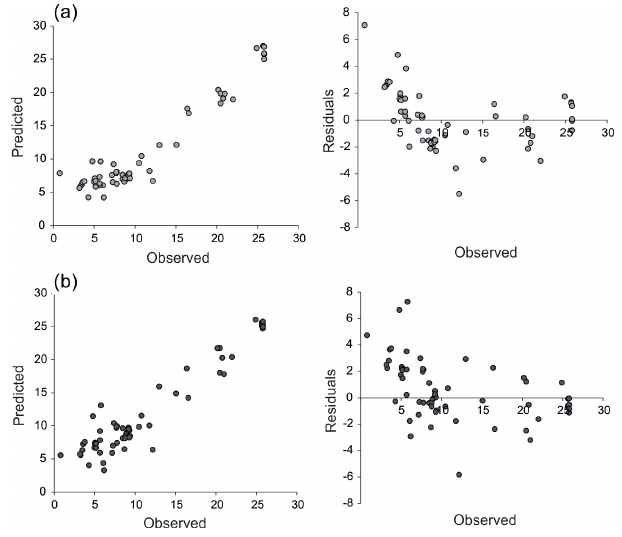
Figure 6. Model performance of the best-performing clas- sical method (WA) and Bayesian approach. A: weighted averaging method; B: Bayesian method. WA: R 2 RMSEP jack = 2.404 ◦ C, mean bias jack = − 0.017 ◦ C, max bias jack = 4.665 ◦ C. Bayesian: R 2 2.373 ◦ C, mean bias jack = 0.598 ◦ C, max bias jack = 3.158 ◦